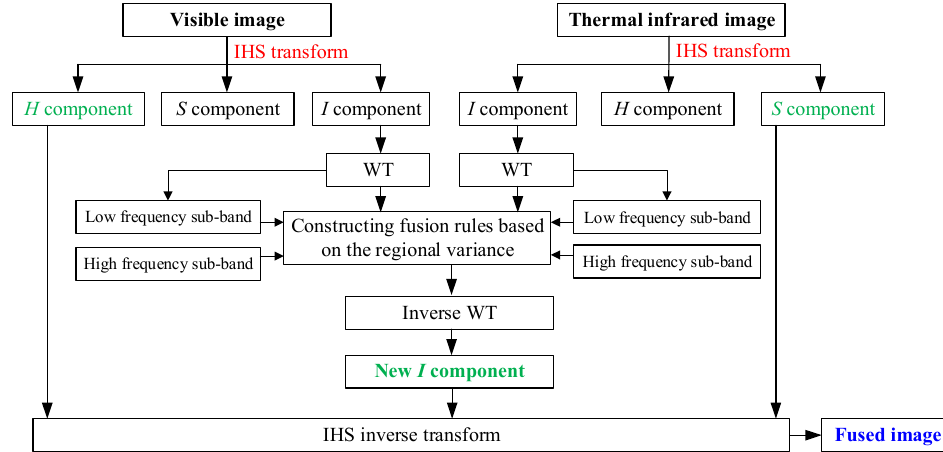
Figure 2. The general workflow of the proposed method to fuse the visible and TIR images. IHS is the intensity hue saturation; WT is the wavelet transform; and H , S , I refer to the hue, saturation, intensity, respectively.